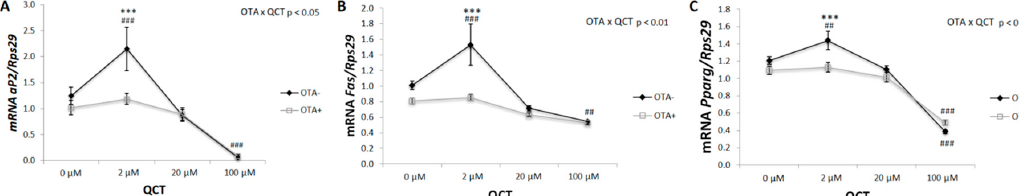
Figure 3. Gene expression of adipogenic markers in differentiated primary rat preadipocytes cultured with (OTA+) or without the addition of ochratoxin A (OTA-) in cell culture medium and with the addition of quercetin (QCT) at various concentrations. The expression of adipocyte Protein 2 ( aP2 ; = fatty acid binding protein 4; A ), fatty acid synthase ( Fas ; B ) and peroxisome proliferator-activated receptor gamma ( Ppar γ ; C ) was determined by real-time PCR. Data were normalized to the gene expression of 40S ribosomal protein S29 (Rps29), the expression of which was not altered by the treatments. The results, presented as mean ± mean error (SEM), were analyzed by two-way ANOVA with factors QCT and OTA, followed by Bonferroni post-hoc test. The level of statistical significance considered for factor OTA was *** p < 0.001, and for factor QCT ## p < 0.01; ### p < 0.001.